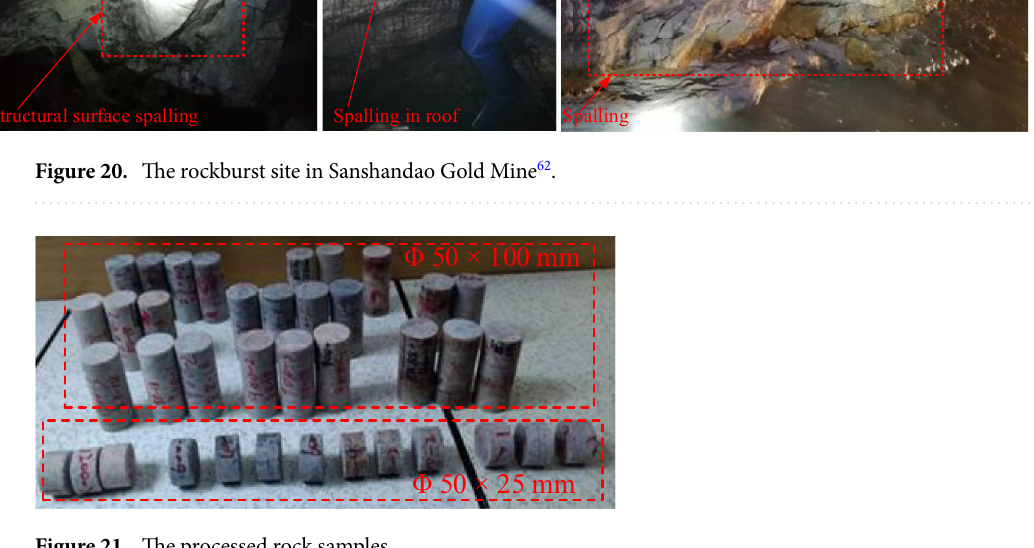
Figure 21. The processed rock